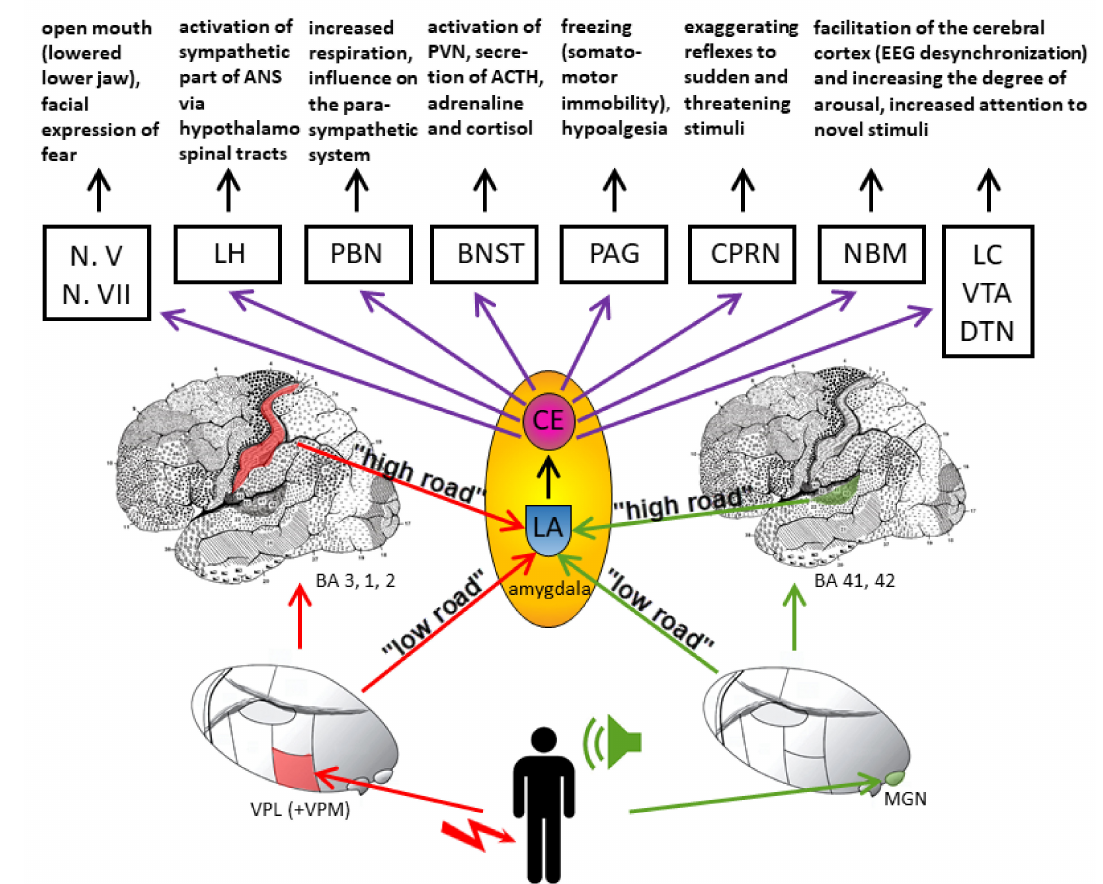
Figure 4. Simplified schematic representation of neural circuits underlying fear conditioning. Pathways that process a conditioned stimulus (CS, auditory pathway, green) and an unconditioned stimulus (US, spinothalamic anterolateral pain pathway, red) via the ventroposterolateral (VPL) and ventroposteromedial (VPM) nuclei and the medial geniculate body (MGN) of the thalamus monosynaptically, and via the cerebral cortex of Brodmann’s areas 3, 1, and 2 (primary somatosensory cortex); 41 and 42 (primary auditory cortex) polysynaptically converge on the lateral nucleus of the amygdala (LA, the LA receives the majority of afferent fibers). CS-US convergence in LA initiates long-term potentiation (LTP), leading to the creation of a learned association between the two stimuli. LA activity is then transferred to the central nucleus (CE, the central nucleus of the amygdala), which sends most of the efferent projections to a number of different cortical and subcortical areas through which the amygdala directly regulates autonomic responses and context-dependent behavior: ANS, reflexes, and hormone secretion. Sympathetic activation includes mydriasis, tachycardia, hypertension, peripheral vasoconstriction, cessation of peristalsis, sphincter contraction, and other effects. All these effects help organisms to cope with threat. Synaptic plasticity also changes in neurons in other nuclei of the amygdala (intentionally omitted here). ACTH—adrenocorticotropic hormone; BA—Brodmann’s area; BNST—bed nucleus of stria terminalis;